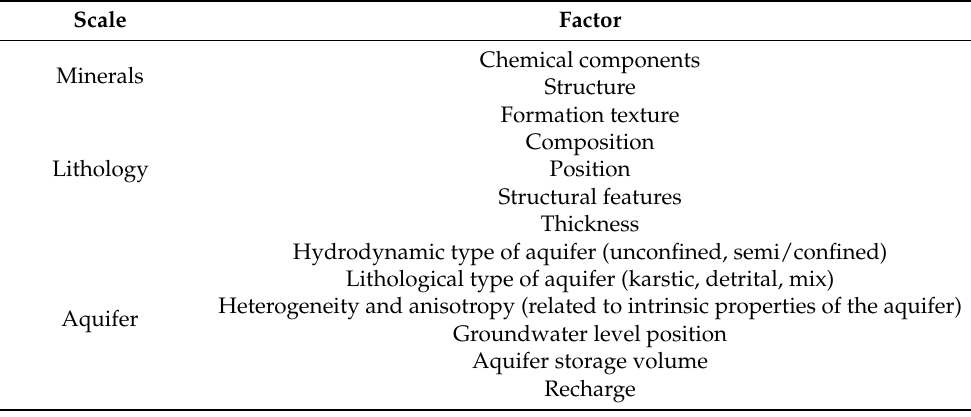
Table 1. Intrinsic factors that contribute to resilience and buffering capacity of groundwater systems across different scales. Hierarchy of organization and selected